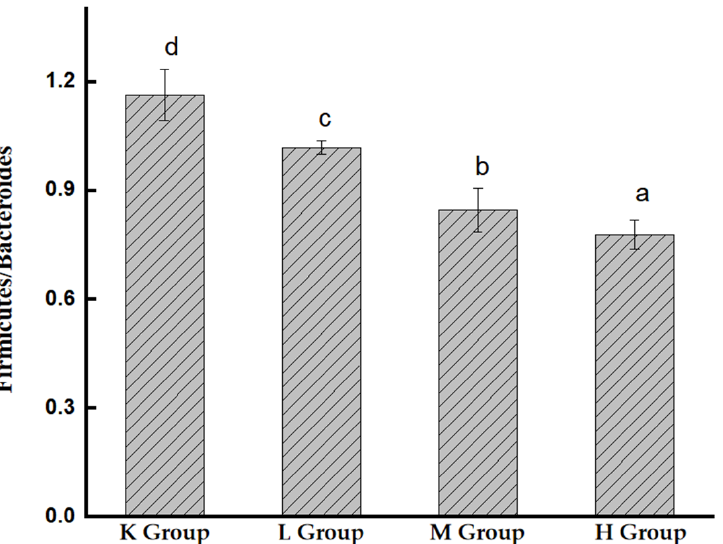
Figure 8. The ratio of Bacteroidetes/Firmicutes in the intestinal flora of mice. Different lowercase letters indicate significant differences ( p < 0.05).